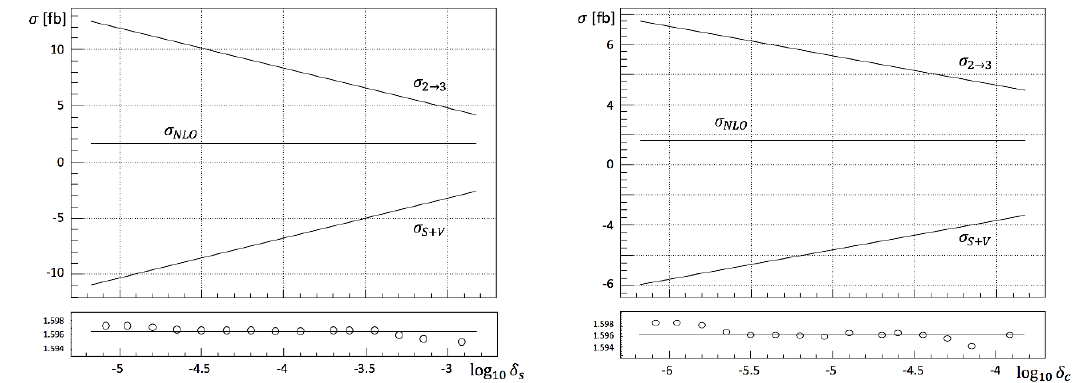
Figure 4 . Dependence of the NLO cross-section for the pp ! CC on the soft cut-o(cid:11) (cid:14) s (left) and the collinear cut-o(cid:11) (cid:14) c (right). Both plots are for a pp center-of-mass energy of coloron mass M = 1 TeV, and renormalization and factorization scales (cid:22) = (cid:22) F = M . Furthermore, in the left (right) panel, the (cid:12)xed value (cid:14) c = 10 (cid:0) 5 ( (cid:14) s = 10 (cid:0) 3 : 5 ) has been